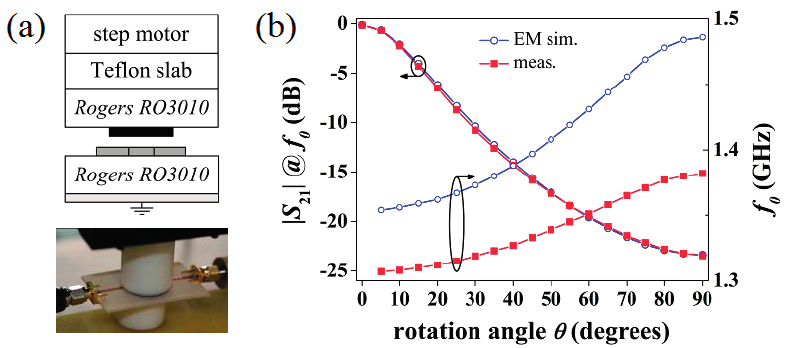
Figure 22. ( a ) Experimental set-up, and ( b ) notch magnitude and frequency versus the angular displacement. The frequency shift between measured and simulated data is attributed to substrate- and fabrication-related tolerances ( f 0 is very sensitive to the resonator parameters). From [47]; reprinted with permission IEEE